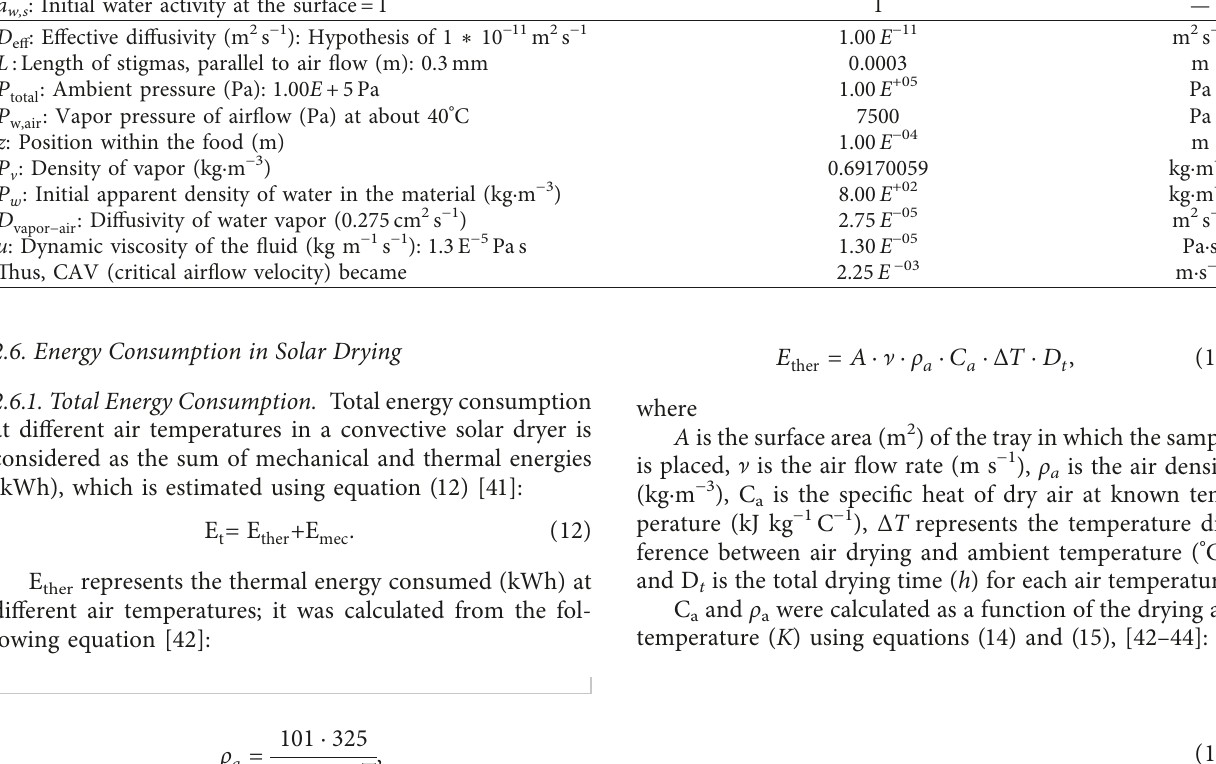
Table 2: Physical data for estimating the CAV value of Crocus sativus L. stigmas. a w,s : Initial water activity at the surface �